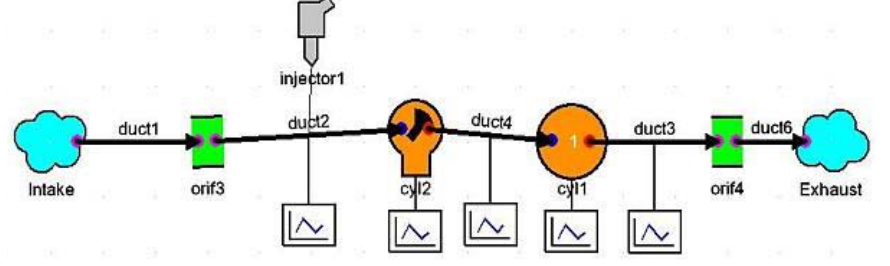
Figure 4. The 31 cc-baseline model.